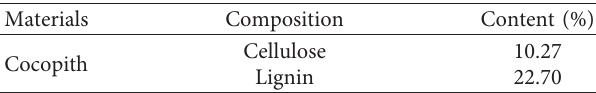
Table 1: The results of the lignocellulose composition test on